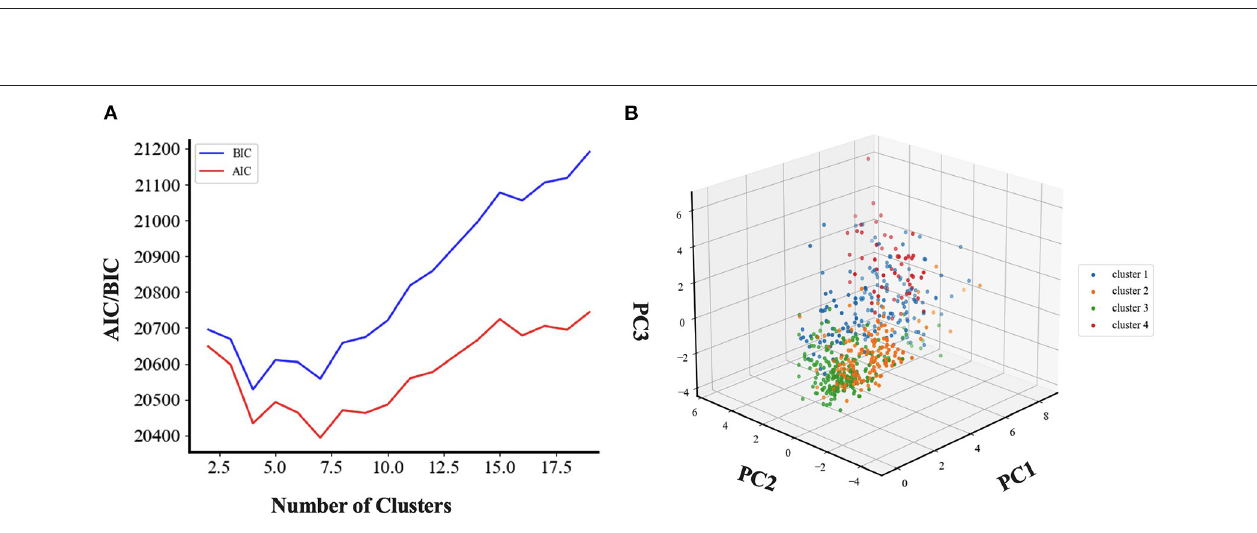
Frontiers in Medicine |